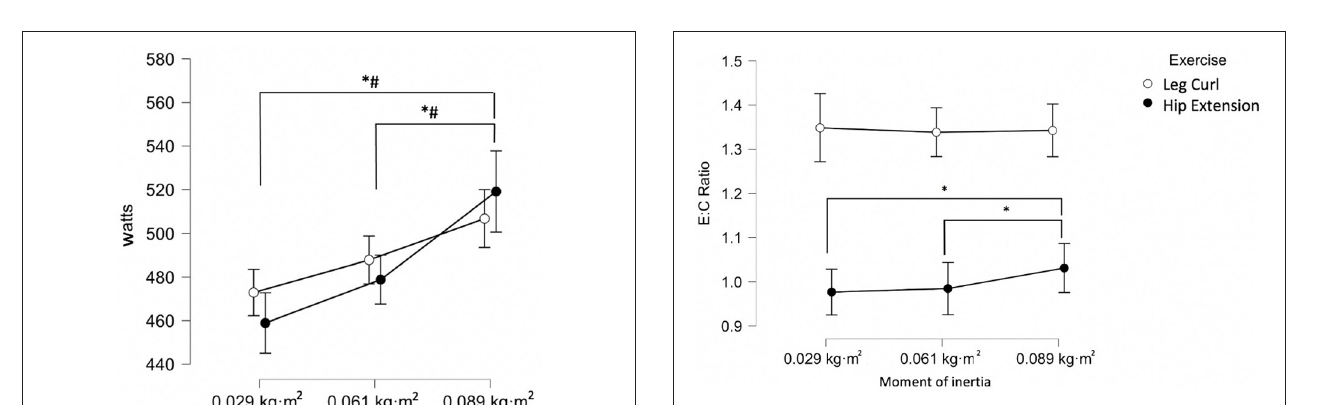
Cohen’s d ( Interpretation )